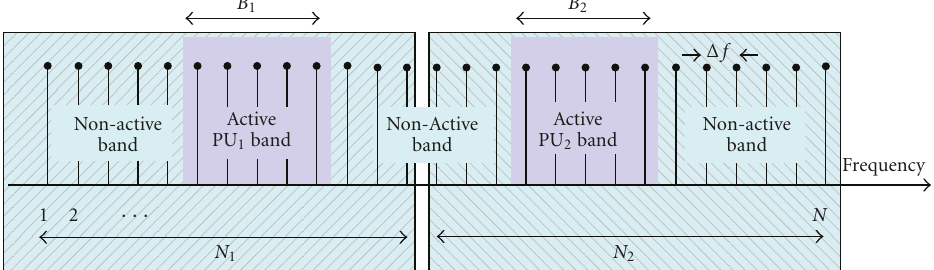
Figure 6: Frequency distribution with two active PU bands.